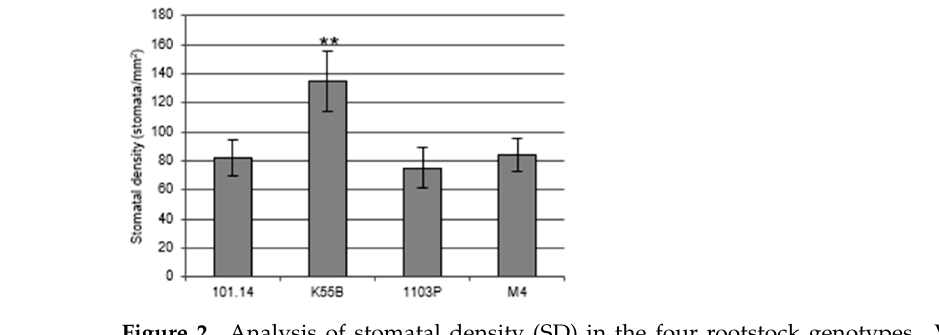
Figure 2. Analysis of stomatal density (SD) in the four rootstock genotypes. Values represent means ± standard errors. Asterisks (**) indicate significant differences among genotypes ( p < 0.01, ANOVA).